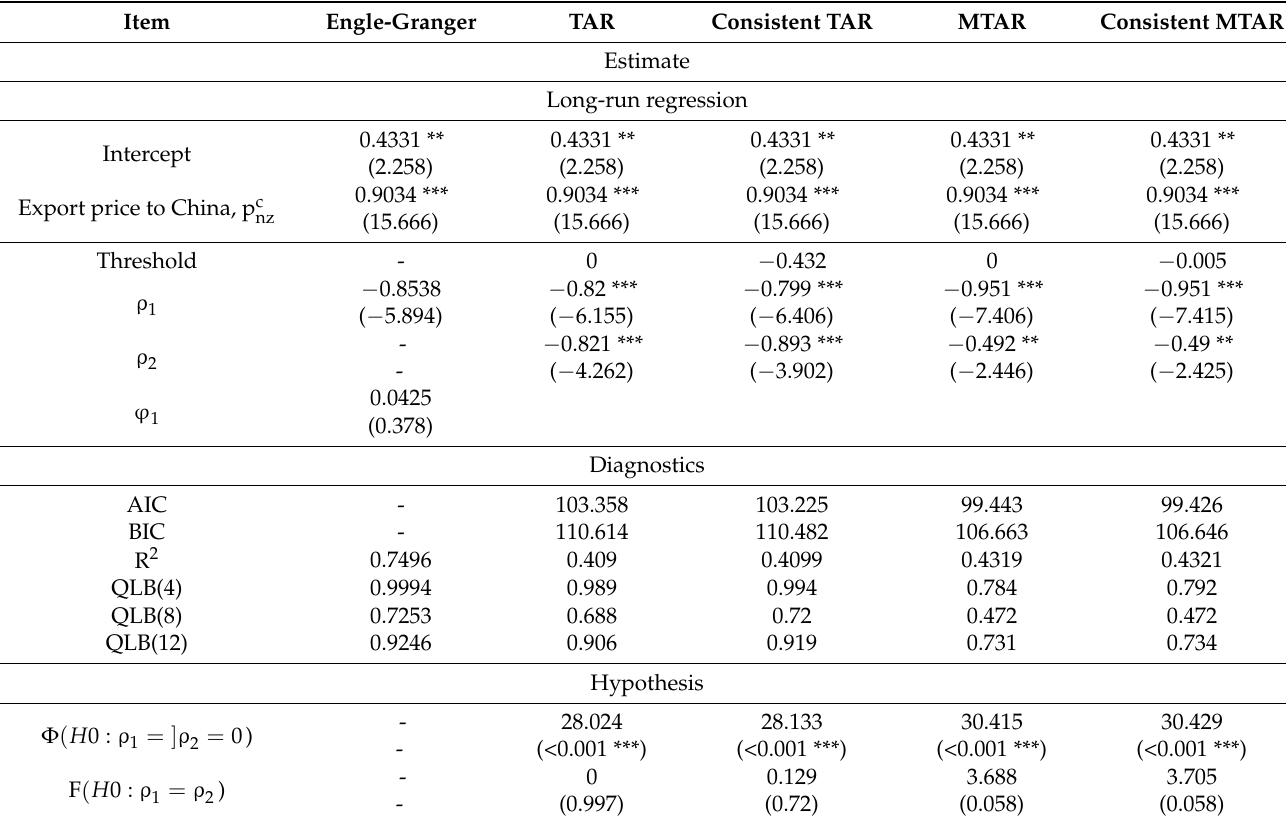
Table 7. Results of Engle-Granger and threshold cointegration tests on SMP export prices of New Zealand and Ireland to